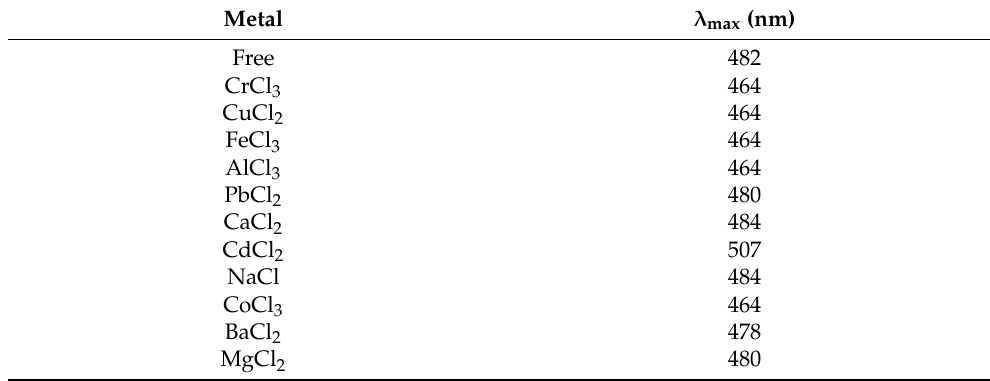
Table 2. Absorbance maxima of the hydrazone dye in CH 3 CN/aqueous (1:10) media of different metal